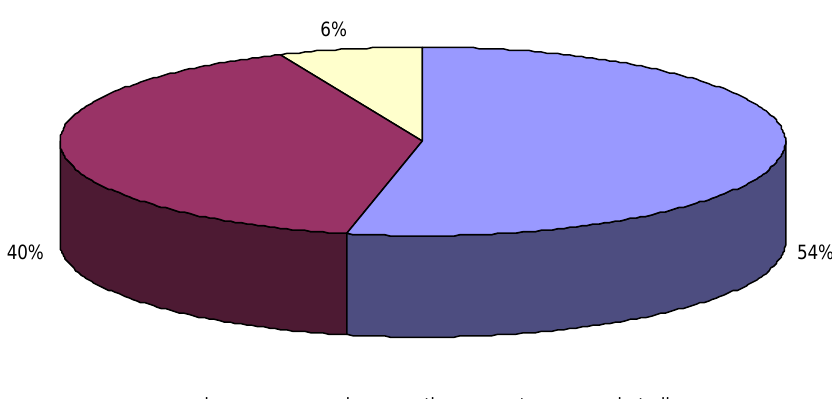
Figure 3. The level of attitude on hygiene and sanitation in schools.